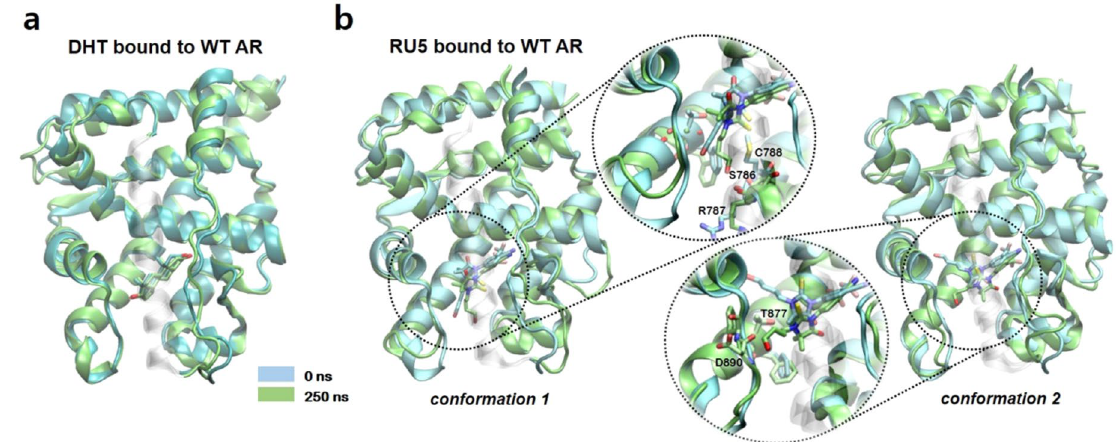
Figure 3. The wild type ARs bound to the agonists. ( a ) The snapshots of the initial structure (PDB ID: 2PIP) of the wild type ARs bound to DHT and the resulting structure after 250 ns aMD simulations. Initial and 250 ns simulated structures are colored in cyan and lime, respectively. ( b ) The wild type ARs bound to RU5s. Initial structures and 250 ns aMD simulated structures are colored in cyan and tan, respectively. Images were created by using VMD v1.9.3 52 .